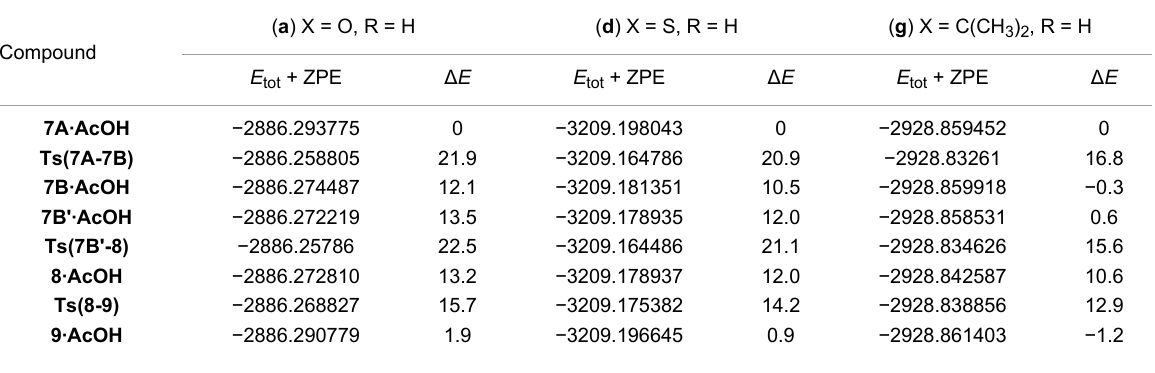
Table 1: Total energies with zero-point energy correction ( E tot + ZPE, а .u.) and relative energies ( Δ E , kcal/mol) of the intermediates and corres- ponding transition states (Ts) occurring along the reaction path of the formation of 1,3-tropolones 5 , and 6a , d , g calculated using the PBE0/6-311+G** method in the gas